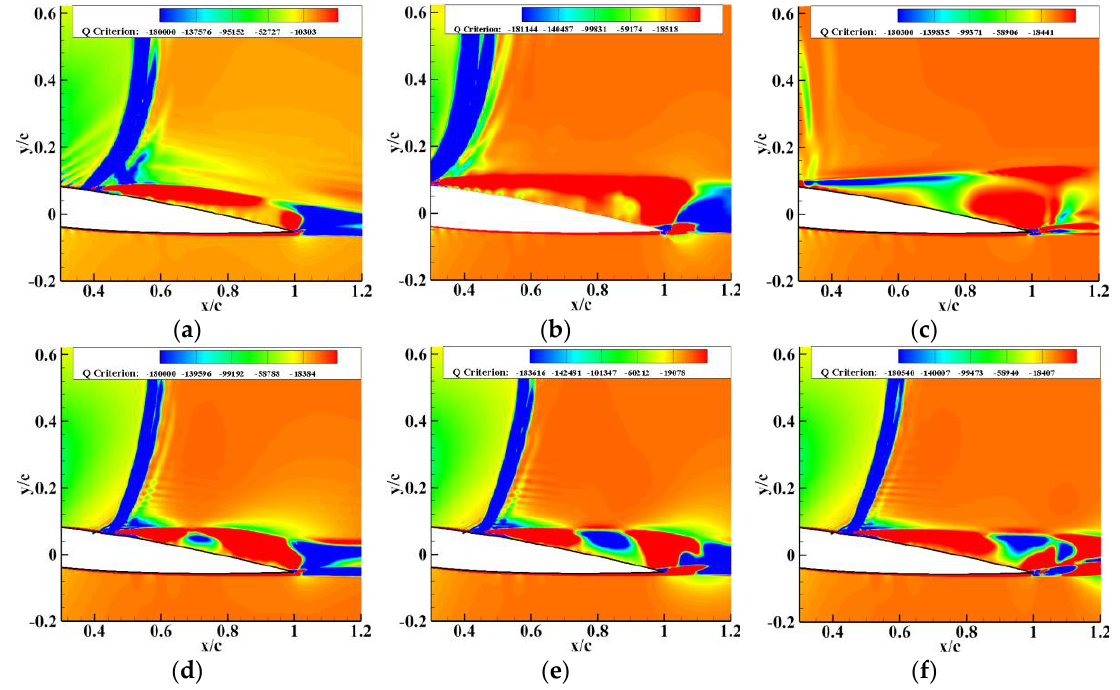
Figure 17. Q-criterion results corresponding to maximum/median/minimum lifts with and without tangential blowing. ( a ) Maximum lift without blowing; ( b ) median lift without blowing; ( c ) minimum lift without blowing; ( d ) maximum lift with blowing; ( e ) median lift with blowing; and ( f ) minimum lift with blowing.